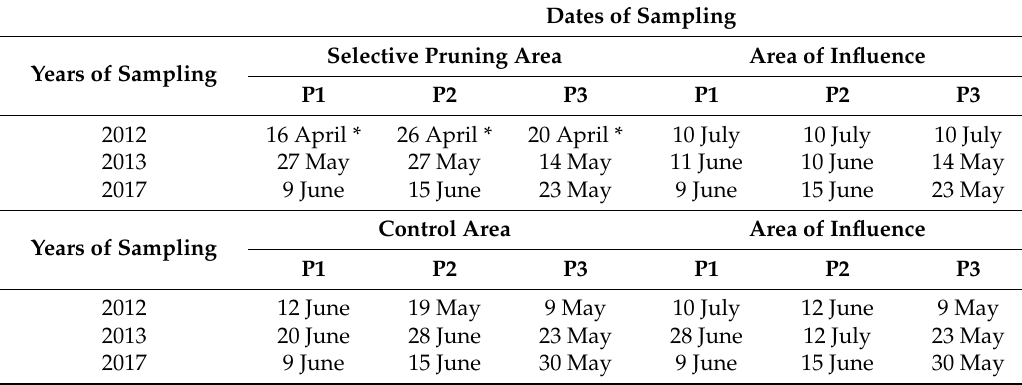
Table 1. Schedule of activities carried out in each of the zones established for each plot during the three years of sampling.